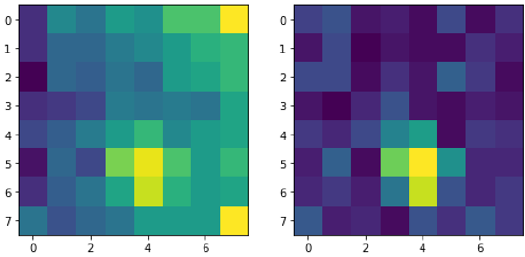
Figure 5. Left; the first frame of the h 13 ( x , y ) recording as an example of raw heat image having one person in the scene. Right; the same frame after applying the background noise removal